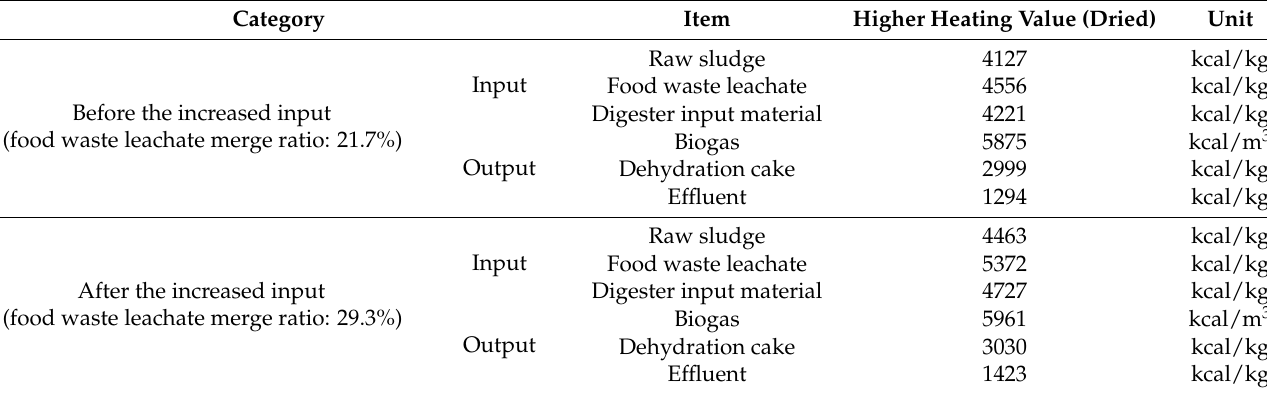
Figure 2. Flow chart of the energy balance analysis model. Table 3. Outline of the energy balance analysis calculation.